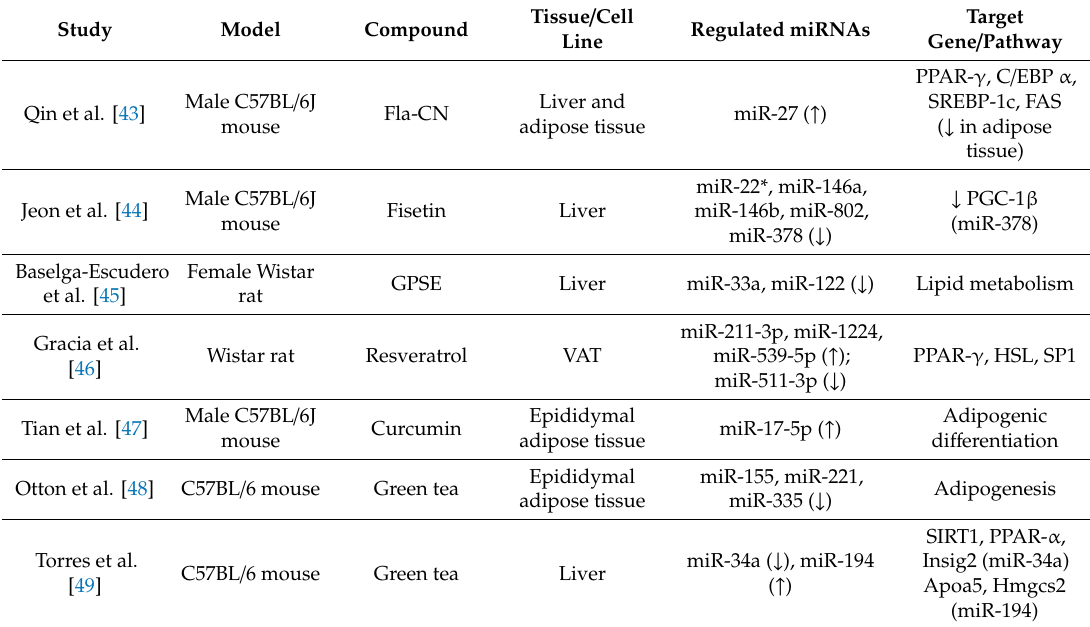
Table 1. Studies that evaluated microRNA expression changes after administration of polyphenols.